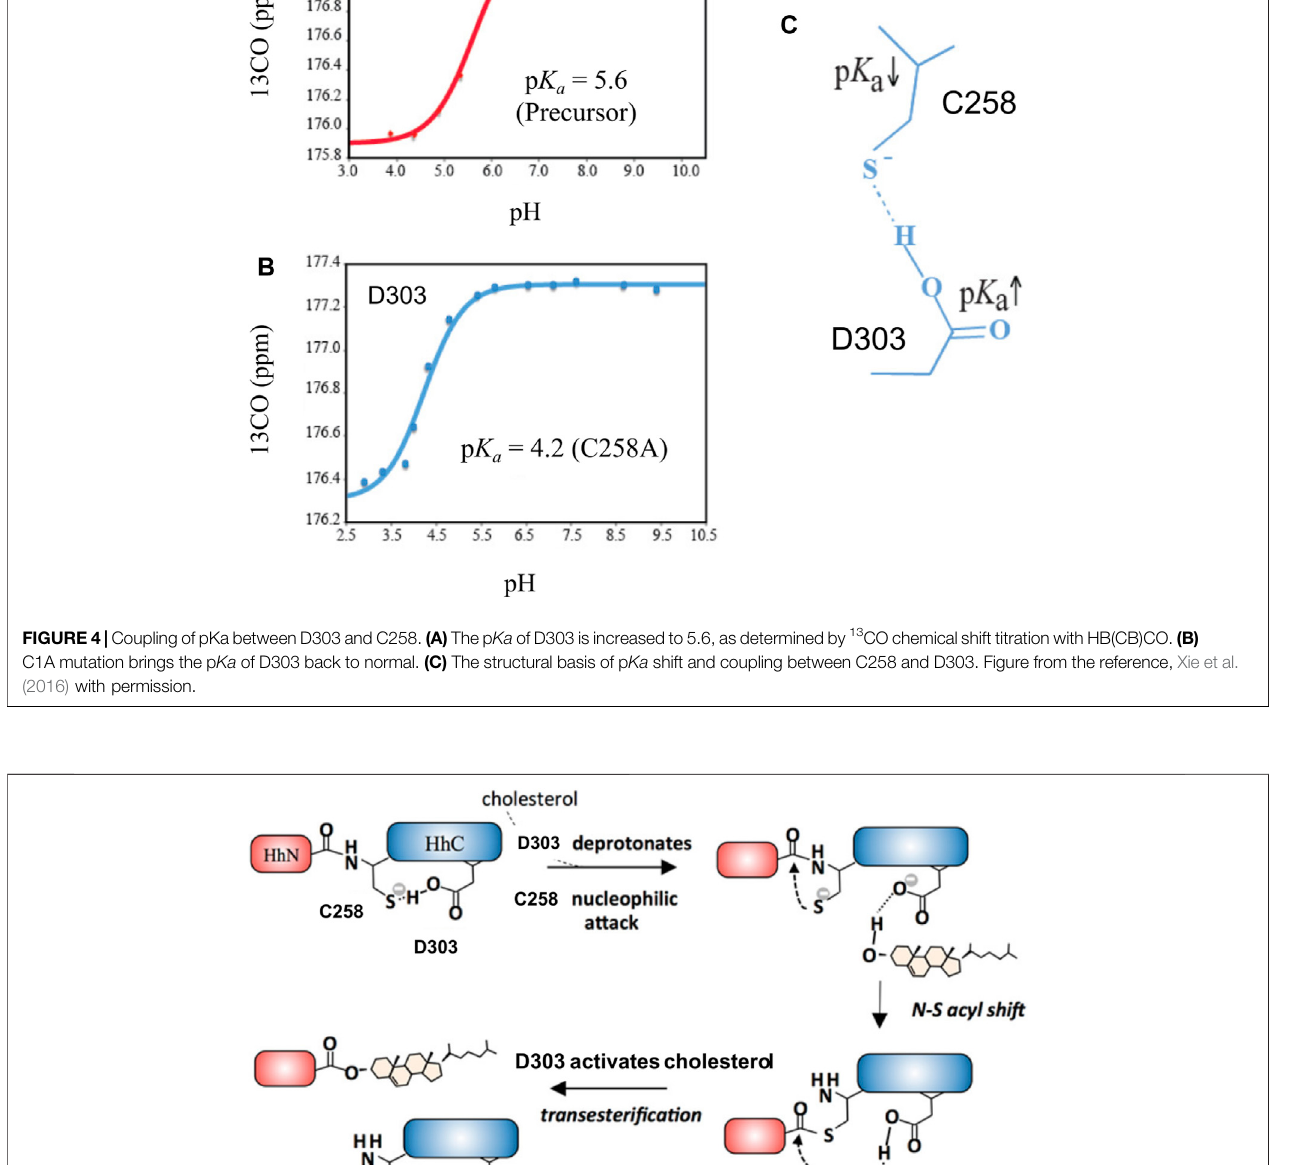
Frontiers in Molecular Biosciences |